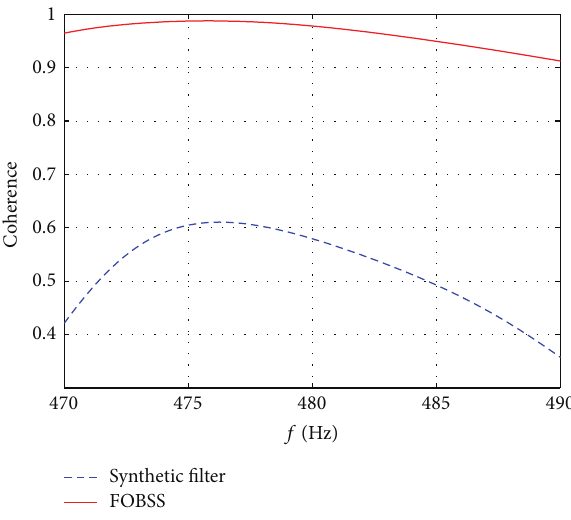
Figure 7: The comparison of frequency-domain coherence.